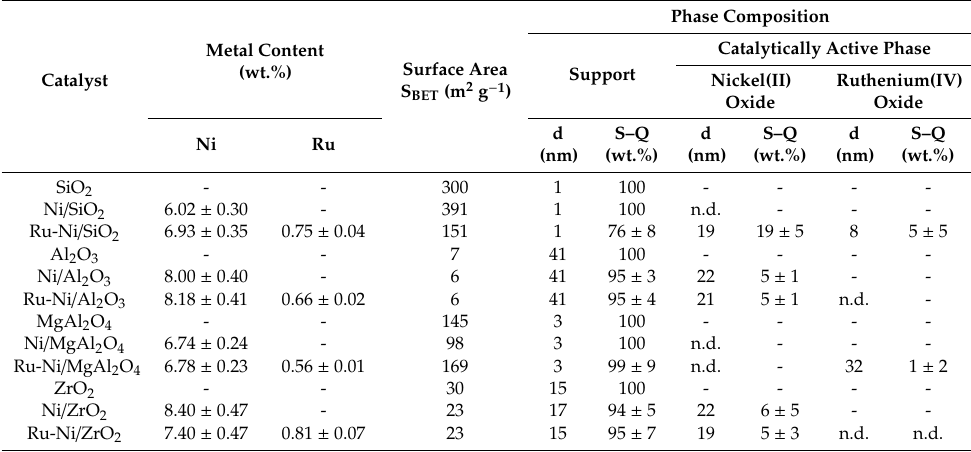
Table 1. Characteristics of the physicochemical properties of Ni and Ni–Ru catalysts.